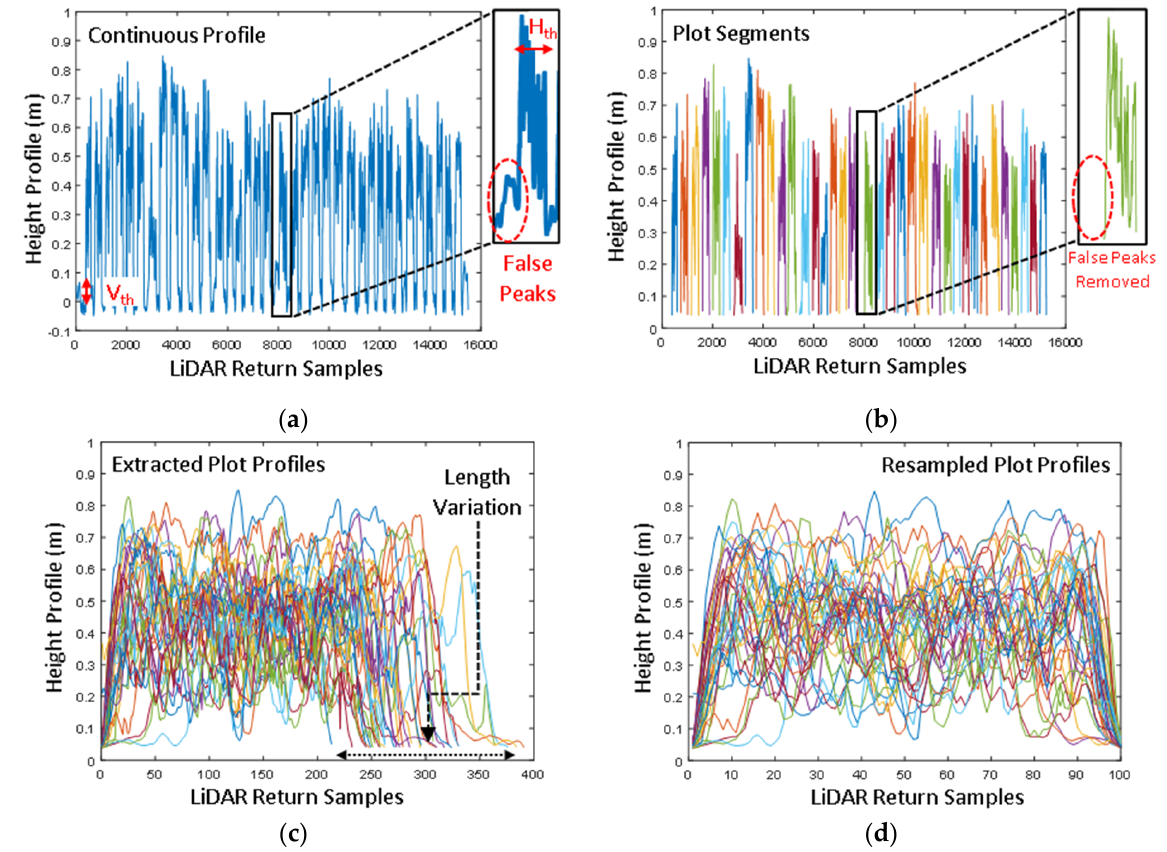
Figure 6. Signal processing to extract the plot profiles. ( a ) The continuous height profile that was measured by the CBM sensor with spurious noise and false peaks, ( b ) removal of the noise, false peaks, and ground profile from the signal; the individual plots were segmented and classified using different colors, ( c ) the extracted plot profiles in high-resolution; the plot profiles varied between 210 and 400 samples due to the variation in the velocity of the mobile platform, and ( d ) the resampled profiles for each of the plot scans.